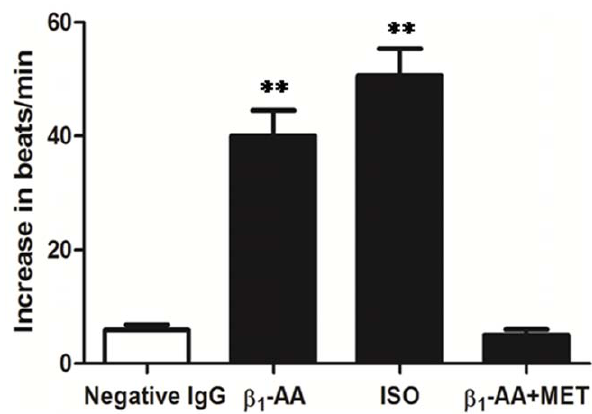
Figure 3. b 1 -AA from DCM patients increased the beat frequency of cultured cardiomyocytes. The bar graph shows the